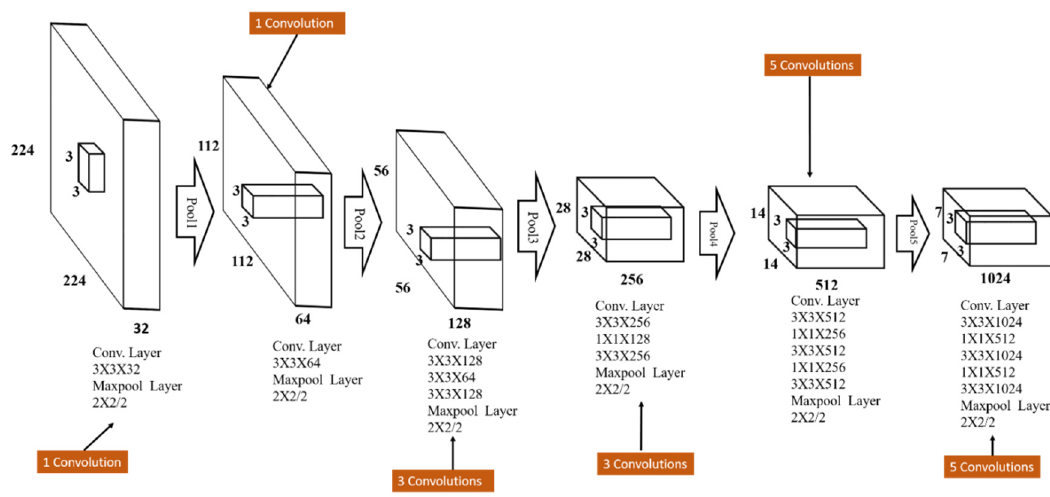
Figure 5. The architecture of the proposed TSBBRs network consisting of 18 convolution layers. Table 1. Configuration of backbone layers.